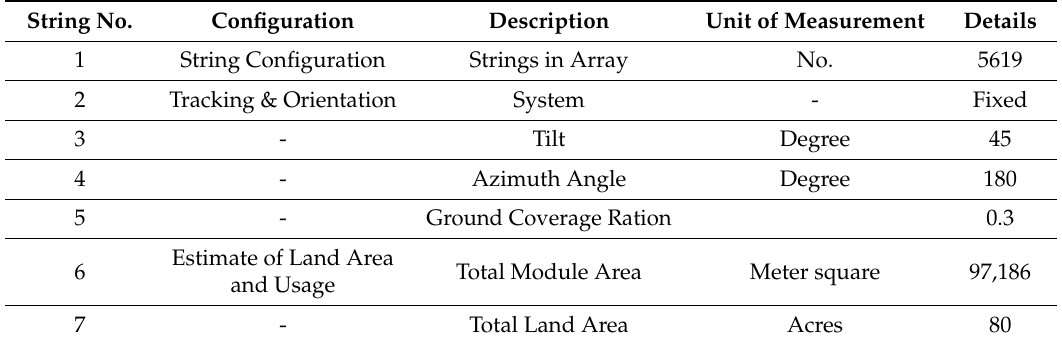
Table 1. The sub-PV array configuration for case 1. Note: Azimuth indicates the horizontal direction of the solar array and tilt is the tilt angle of the modules with respect to the ground. String No.